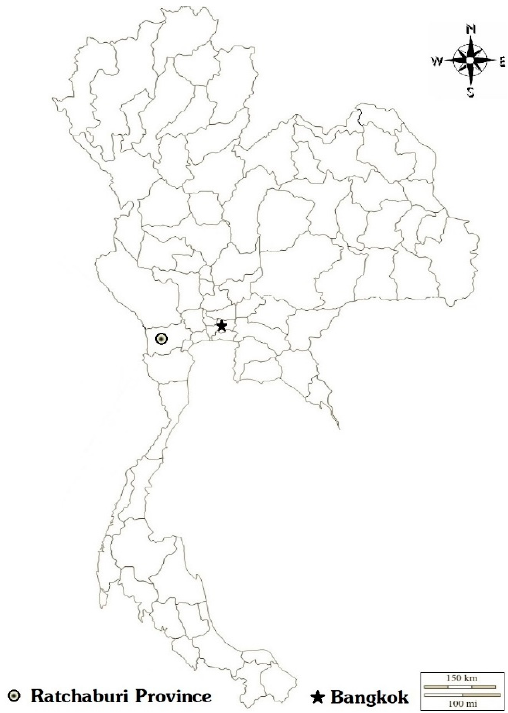
Figure 1. Participating Schools in Ratchaburi province, Thailand, 2006–2009. The circle indicates the location of schools, and the star indicates the location of the Faculty of Tropical Medicine, Mahidol University (Bangkok).